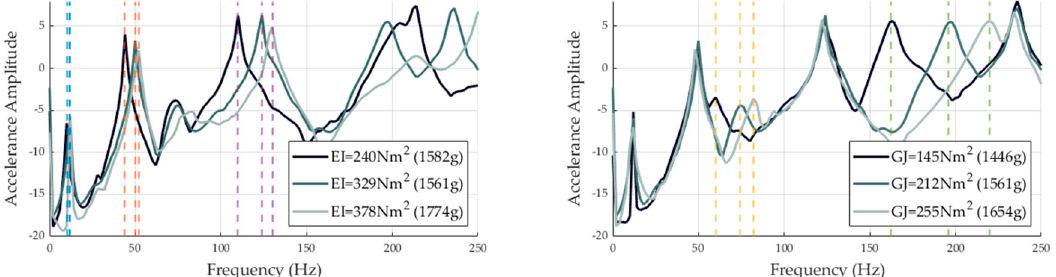
Figure 3. Mean accelerance frequency response function (FRF) of custom skis with varying: ( left ) bending stiffness; ( right ) torsional stiffness.